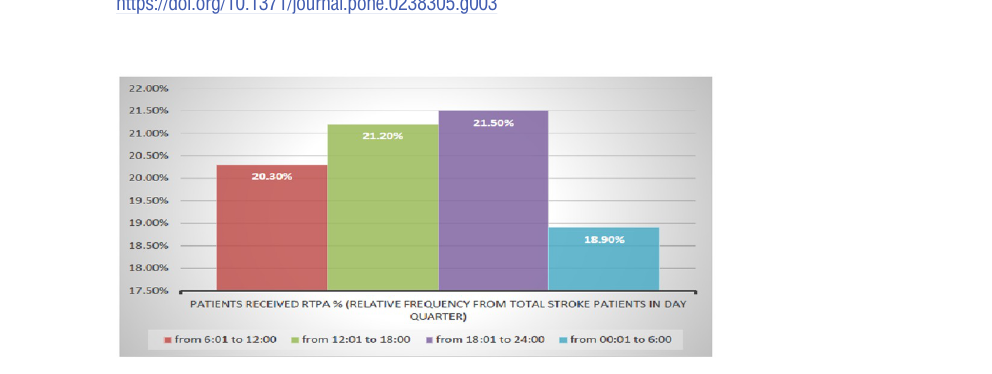
Fig 4. Percentage of patients received rtPA along the 4 quarters of the